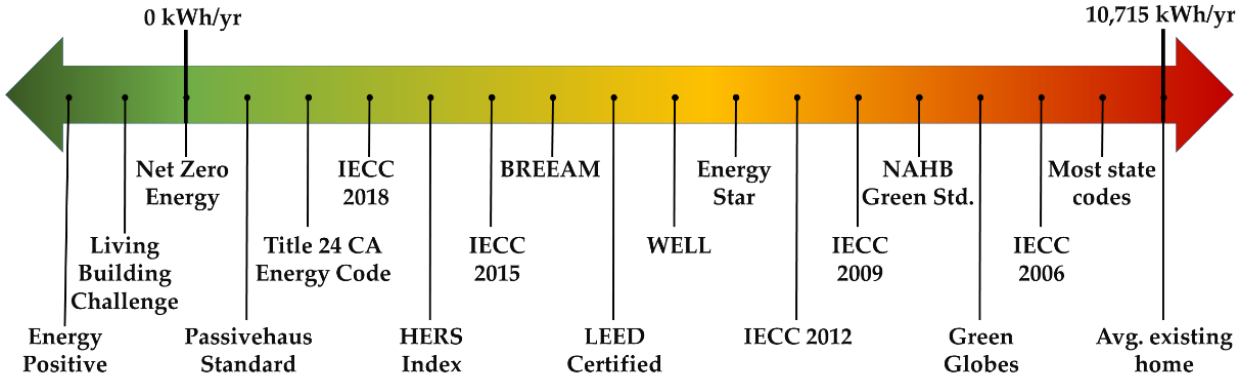
Figure 3. Ranking of energy certificate policies and standards. Each policy/standard is ranked from least energy use potential to most energy use potential. The standards range from energy positive at less than 0 kWh/year to the average US existing home of 10,715 kWh/year (data source: [65]). Examples of such certificate programs specific to sustainable buildings